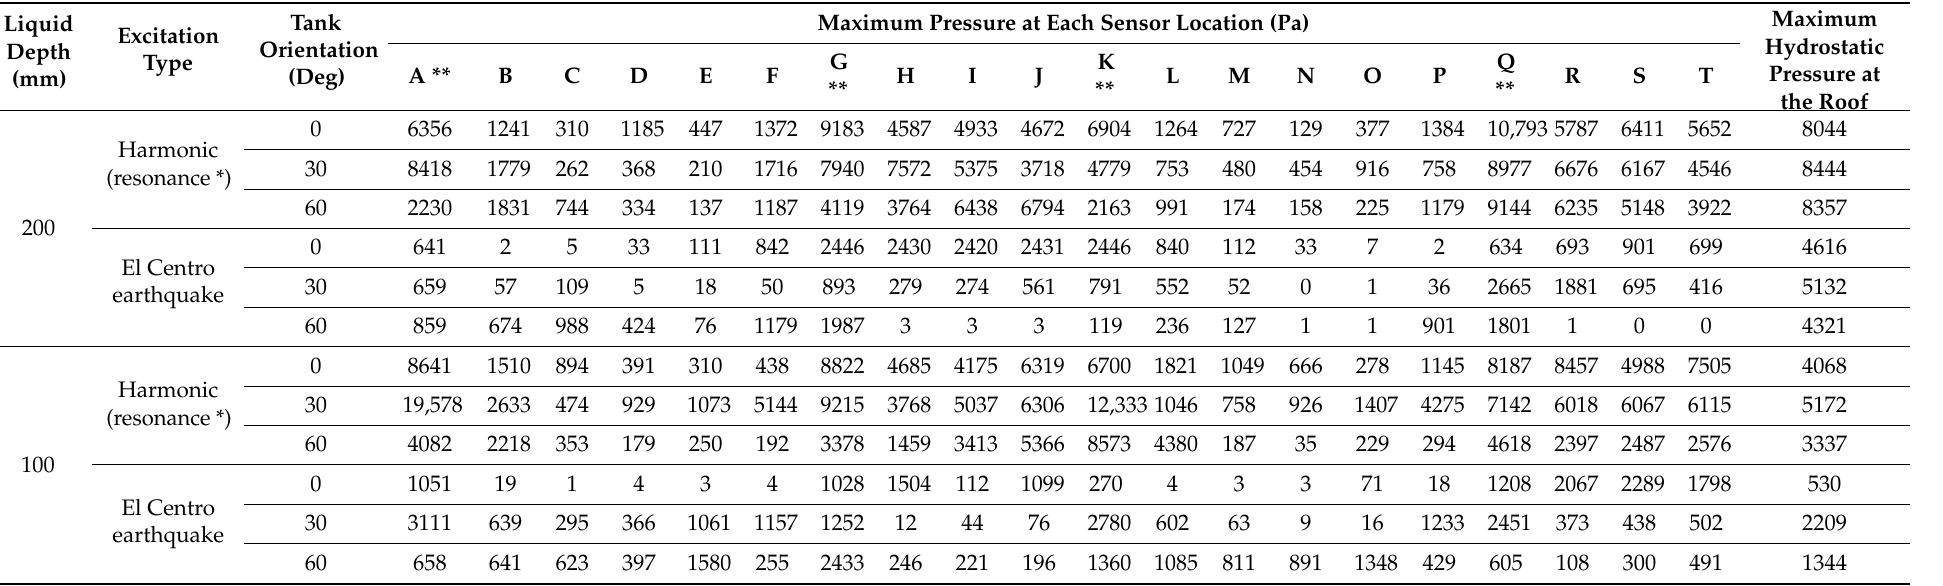
Table 2. Maximum hydrodynamic pressure calculated at each sensor location and the equivalent hydrostatic